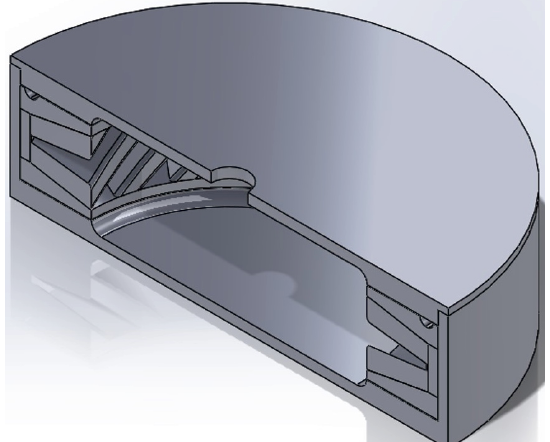
Figure 8. CAD model of the assembled final can design.